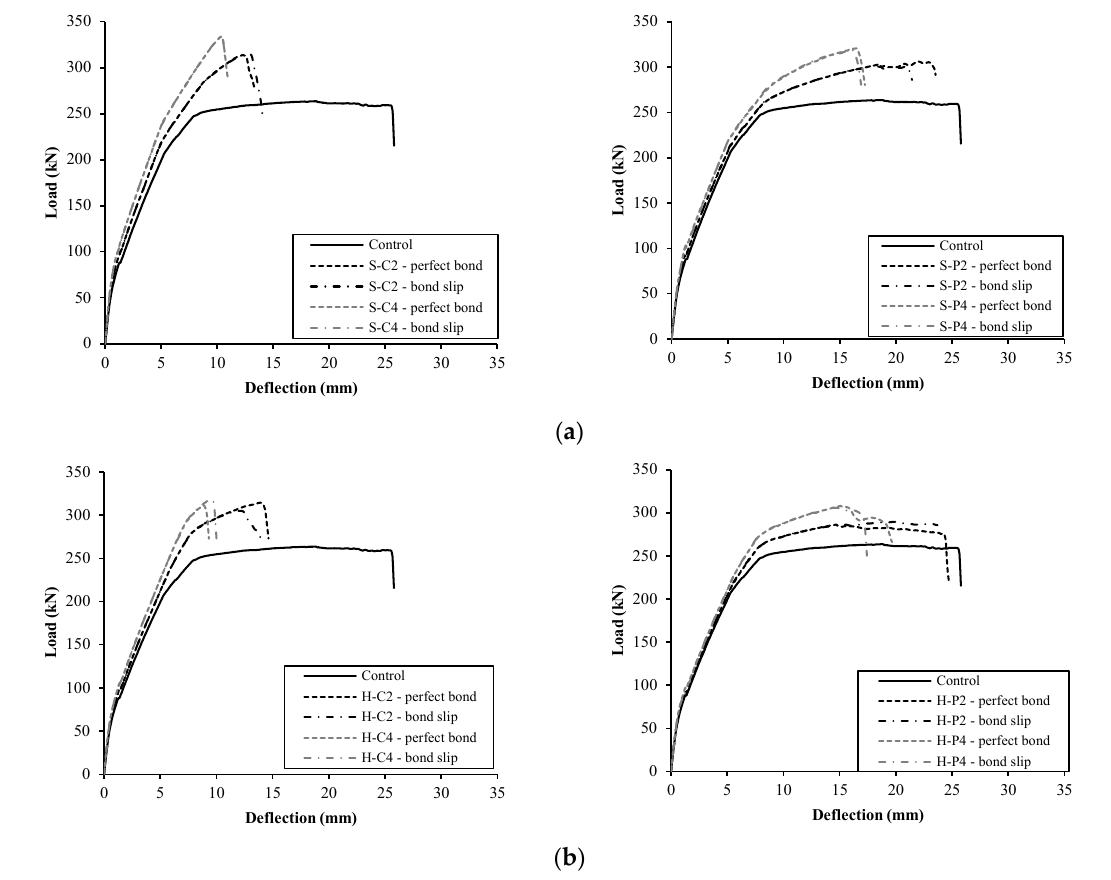
Figure 17. Numerical load-deflection response: ( a ) Group A (sagging strengthening); ( b ) Group B (hogging strengthening).